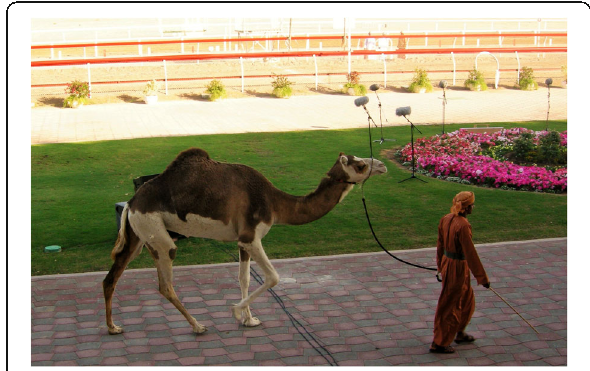
Figure 11 Piebald camel belonging to the Oman Royal Camel Corp (Dioli